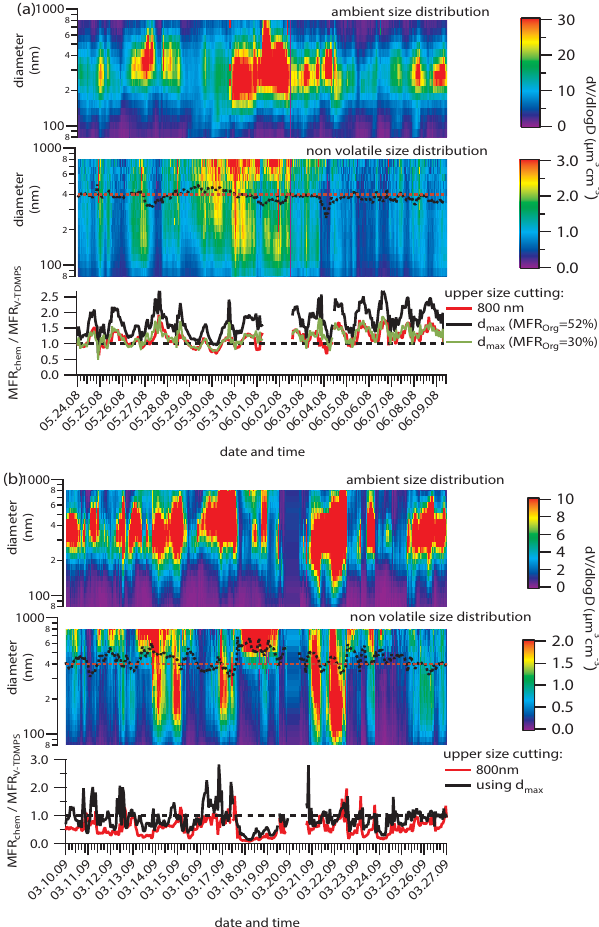
Figure 6. Cross-sensitivity effects of the sea-spray source: Parti- cle volume–size distributions upstream and downstream of the ther- modenuder, and the ratios of the mass fraction remaining (MFR) estimated to measure at the 2 upper size cutting (800nm and d max ) for (a) May–June 2008 and (b) February–March 2009. The black and red dotted lines mark the cut-off estimated using d max approach and the mean d max value, respectively (see Sect.